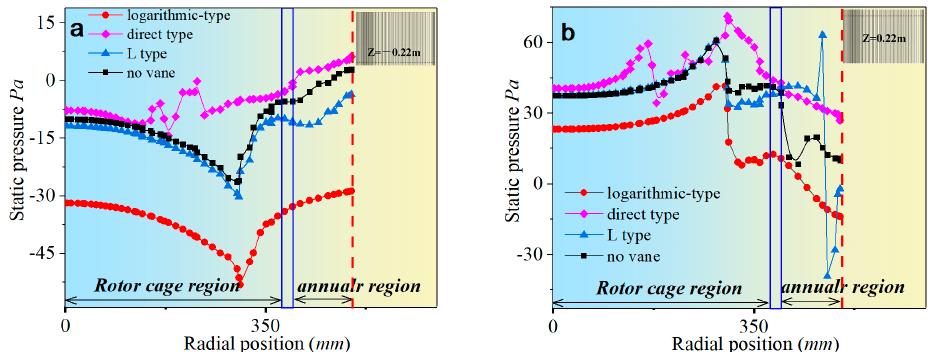
Figure 12. Comparison of the static pressure of rotor cage by four different guide vanes in two sections ( a ) Z = − 0.22 m, ( b ) Z = 0.22 m.